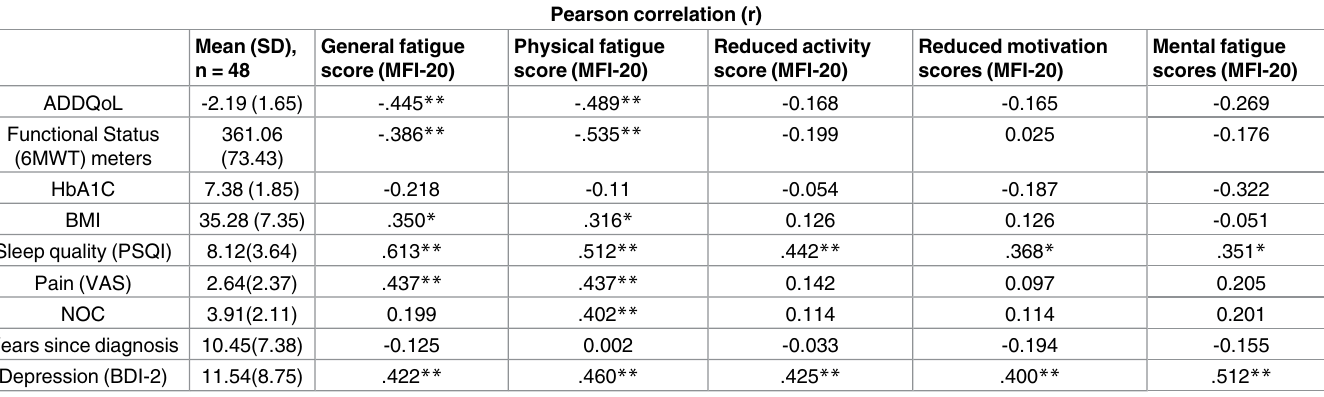
Table 2. Co-relation analysis of fatigue with functional outcomes and contributing factors.